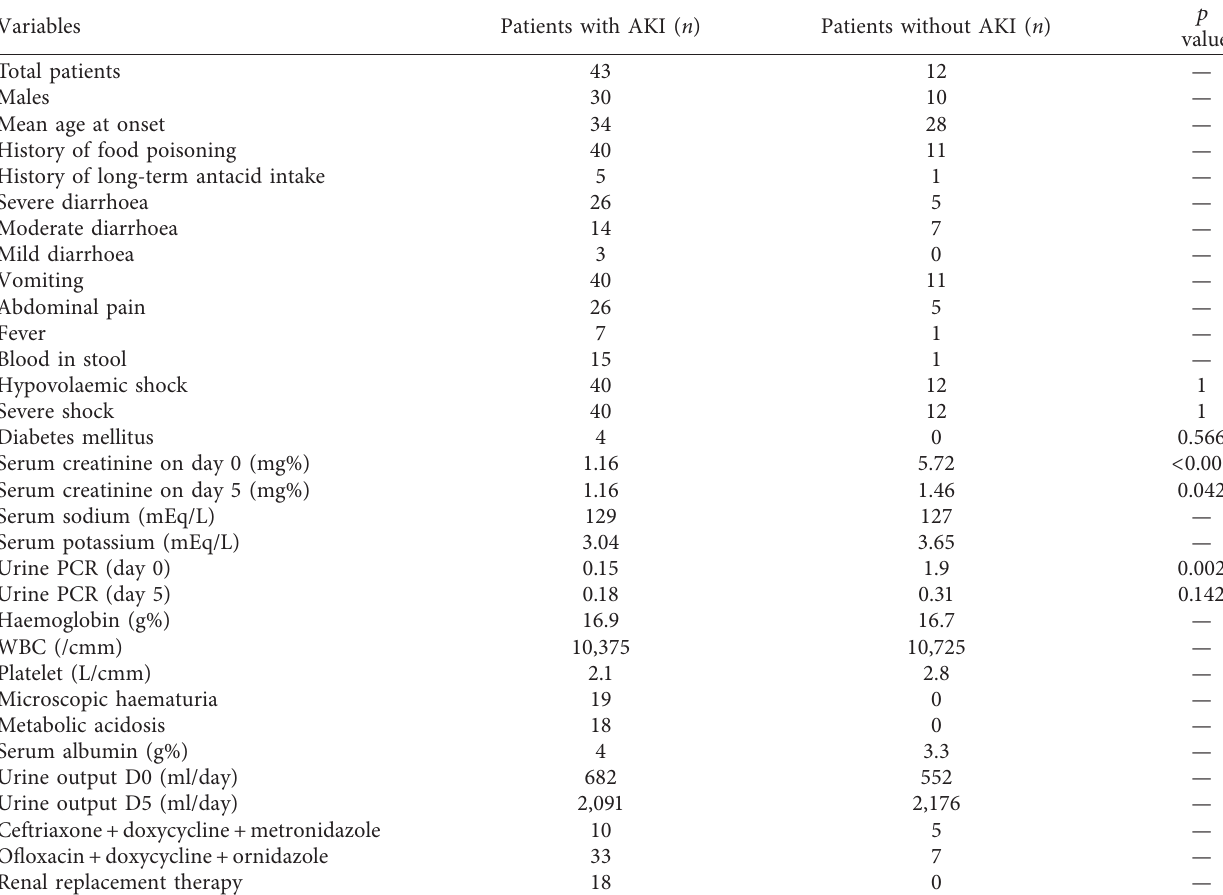
Table 1: Comparison between cholera patients with AKI and without